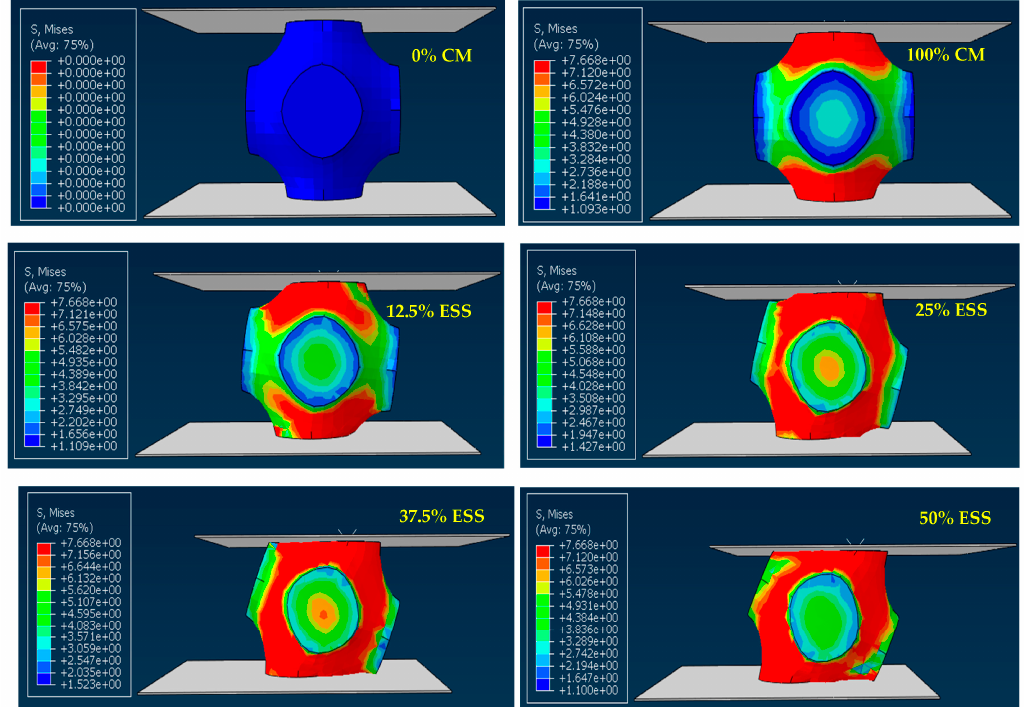
Figure 9. Schematic shear behaviours of the proposed model for monotonic loading procedure at different shear strains with a designed normal pressure of 3.5 MPa. different shear strains with a designed normal pressure of 3.5